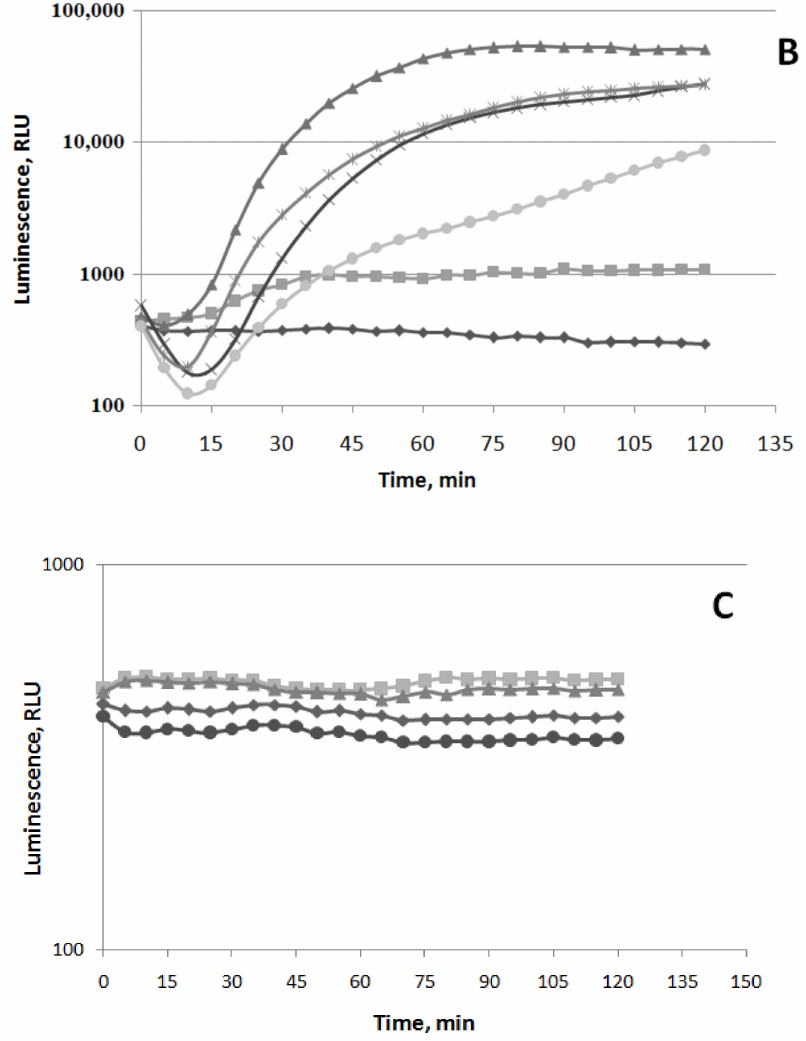
Figure 2. Luminescent response of strain E. coli MG1655 (pKatG’::lux) to hydrogen peroxide ( A ), ( − )-limonene ( B ), and (+)- α -pinene (C). Time course of mean values of light emission (in RLU) in the presence of different chemical concentrations ( A , B ): ( ) 0 µM (black diamond—Control), ( ) 1 µM (gray square), ( ) 5 µM (dark triangle), (×) 25 µM (black cross), ( ) 50 µM (gray asterisk), and ( ) 100 µM (light circle); (C): ( ) 0 µM (black diamond—control), ( ) 5 µM (light square), ( ) 50 µM (gray triangle), ( ) 100 µM (black circle).